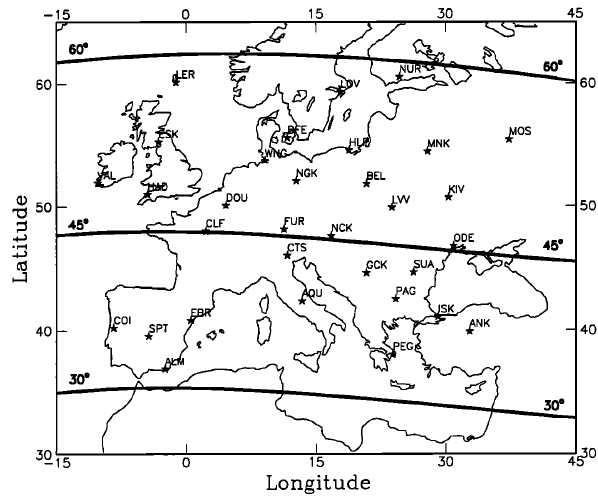
Fig. 11. Locations of observatories used in the European study by Torta et al. (1997). Dip latitude lines are shown for 30 ◦ , 45 ◦ and 60 ◦ Fig 11. Locations of observatories used in the European study by Torta et al (1997) Dip latitude lines are shown for 30°, 45° and 60°. Fig 9. Current systems on 15 May 1990, as for Fig 3. The universal times of the plots range from 23.8 h (labelled 23.00 GMT) on 14 May to 5.8 h (labelled 05.00 GMT) on 15 May.